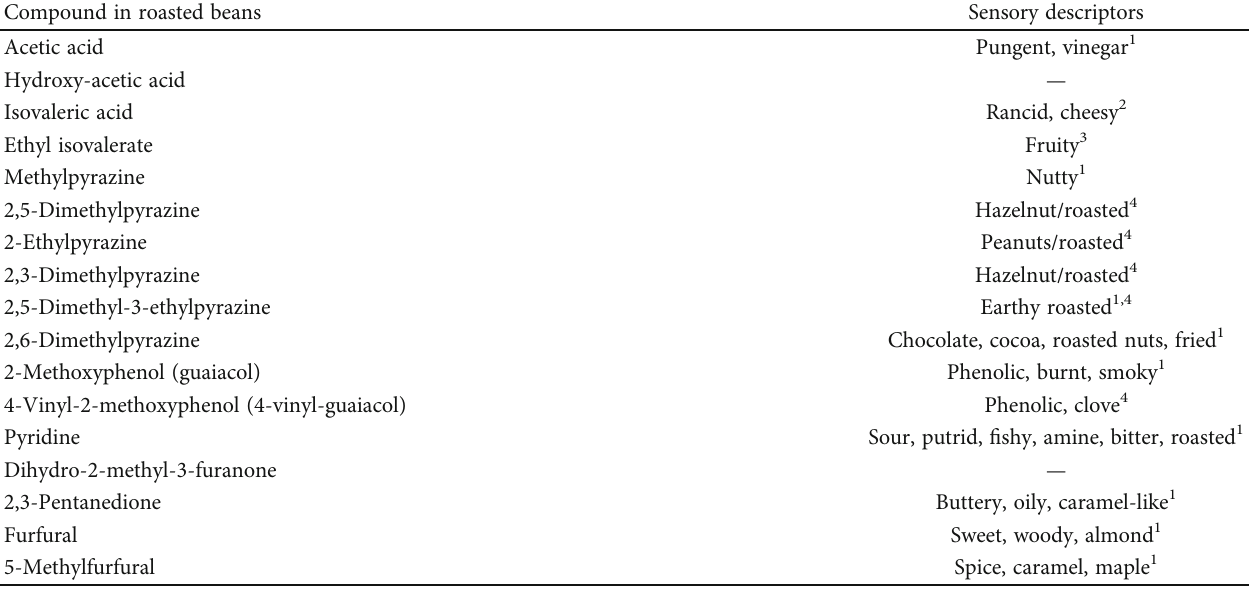
Table 2: Identi fi ed potent aromas in roasted Excelsa co ff ee powder obtained from di ff erent postharvest processing. Compound in roasted